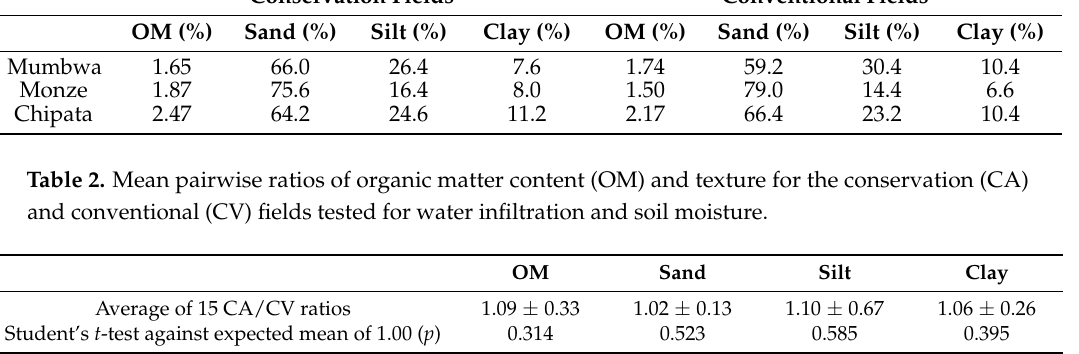
Table 1. Mean organic matter content (OM) and particle-size distribution for fields studied for water infiltration and soil moisture.